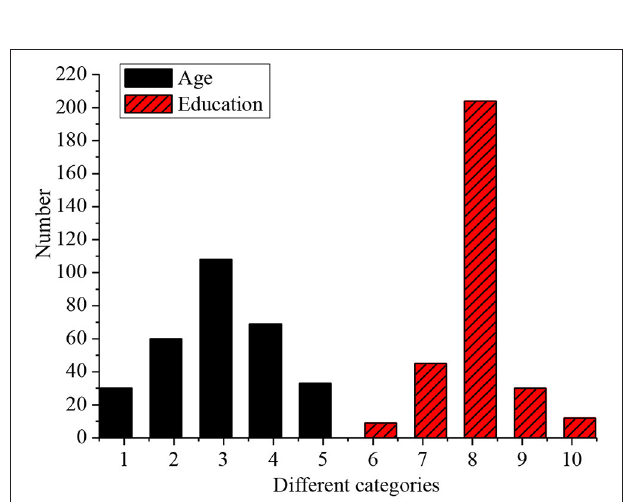
FIGURE 7 | Age and education of the interviewees (1. < 30 years old; 2. 30–35 years old; 3. 35–40 years old; 4. 40–45 years old; 5. Over 45 years